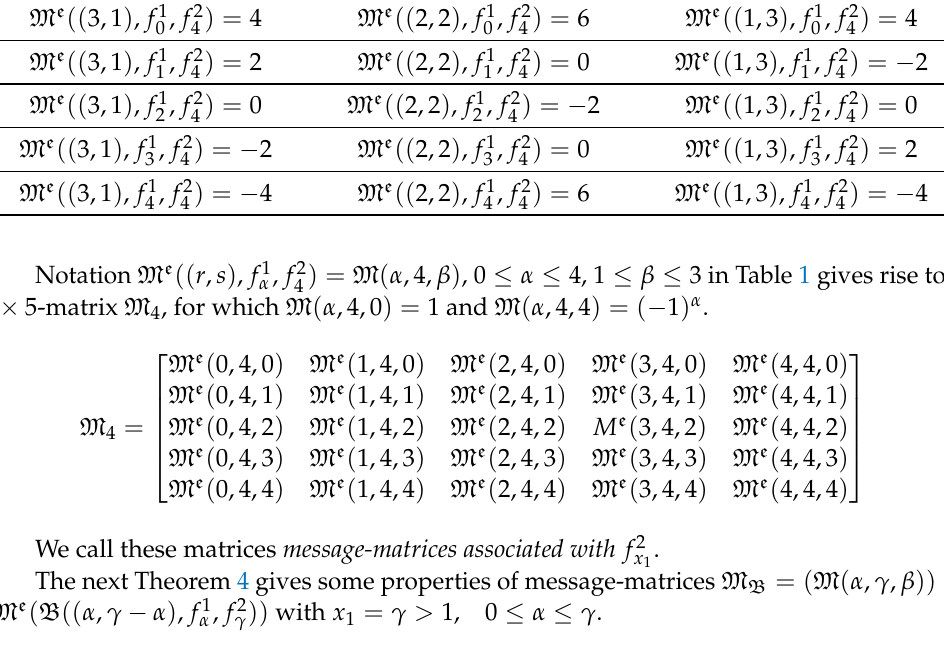
Table 1. Specialized messages of type M e ( B (( r , s ) , y =